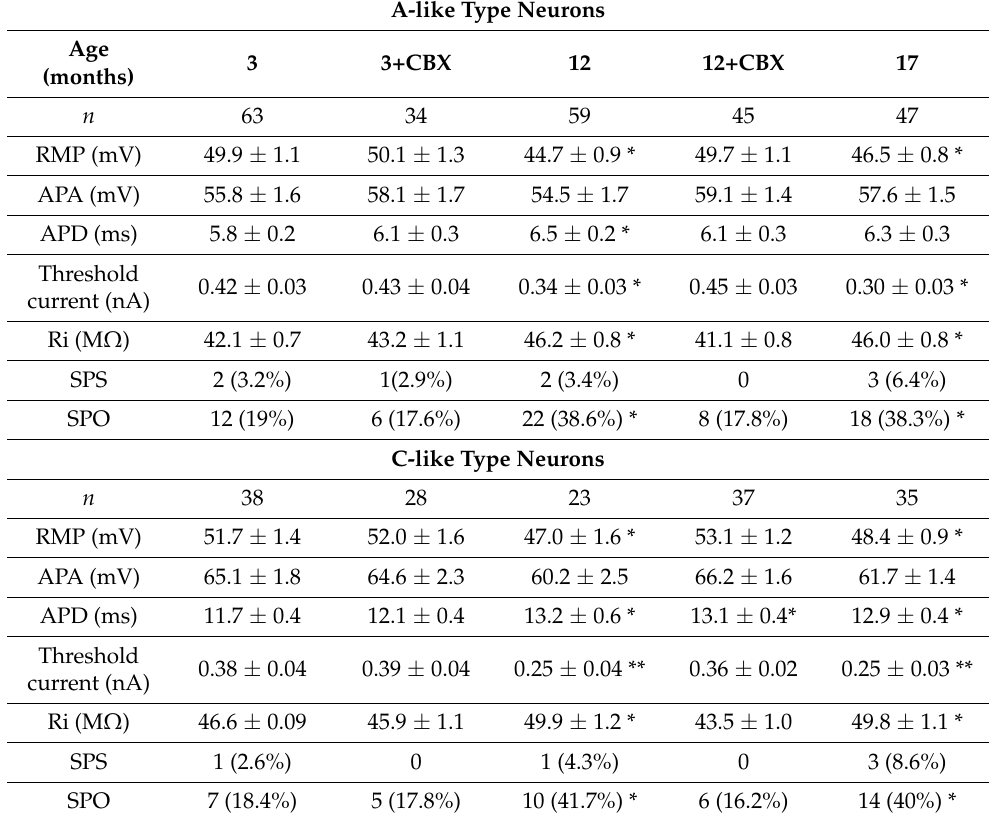
Table 1. Electrophysiological properties of neurons in DRGs of 3, 12, and 17 Mo mice. A-like Type